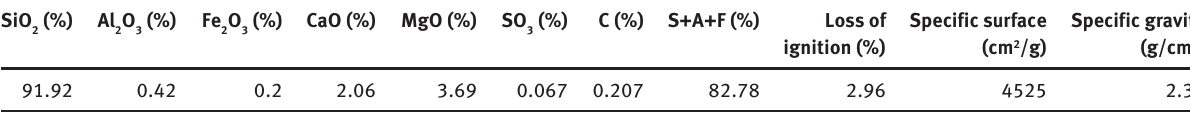
Table 3 Physical and chemical properties of SF. SiO (%) Al O (%) 2 2 3